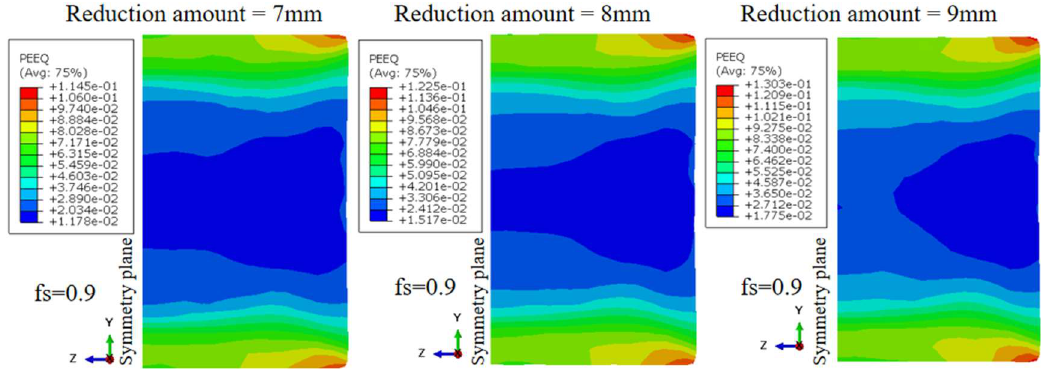
Figure 11. Equivalent plastic strain under different reductions.